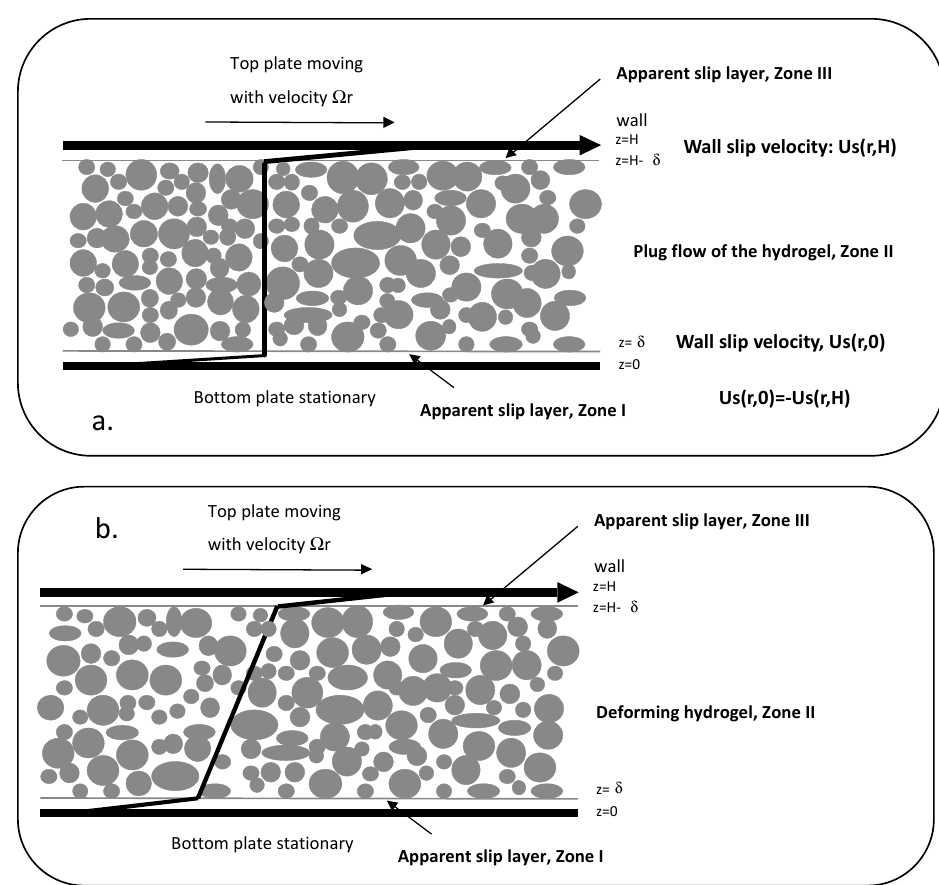
Figure 4. Schematics of the steady torsional flow of a viscoplastic hydrogel ( a ) plug flow with apparent slip ( b ) continuous deformation with apparent slip at the walls.